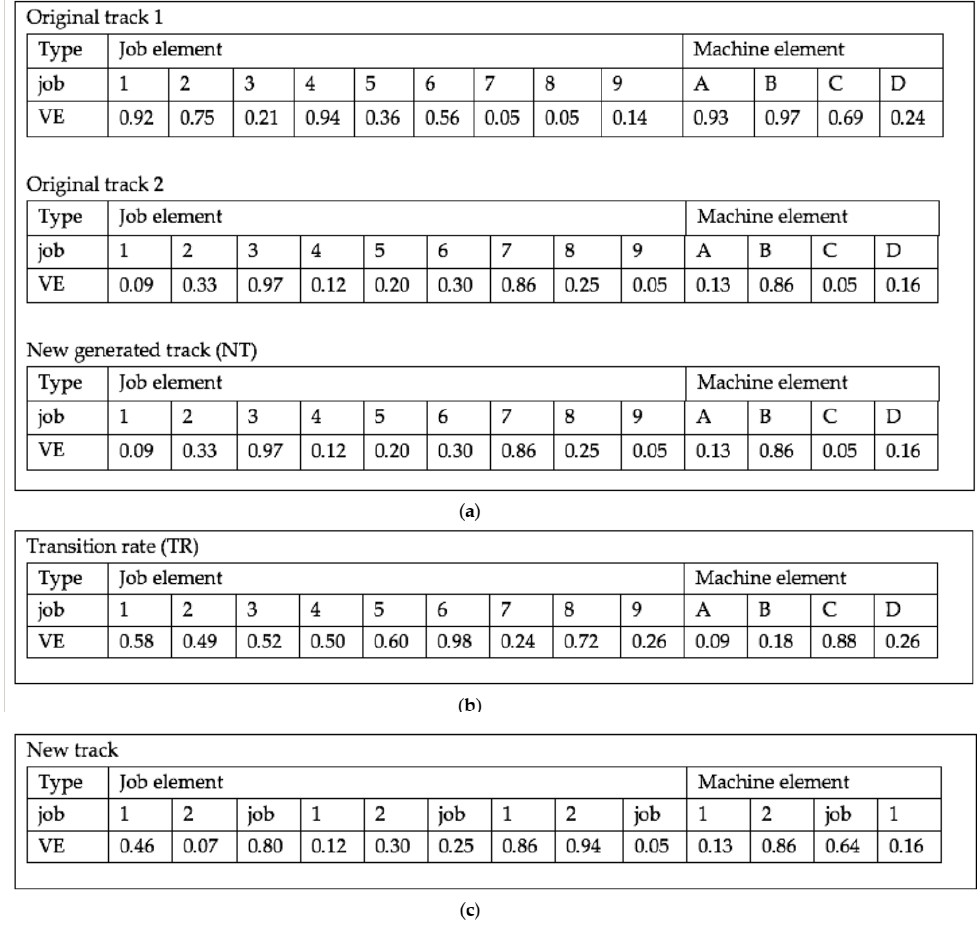
Figure 1. Example of the track-transition method (TTM) procedure: ( a ) Tracks 1 and 2, and new random track; ( b ) Transition rate (TR); ( c ) Result of new transition.